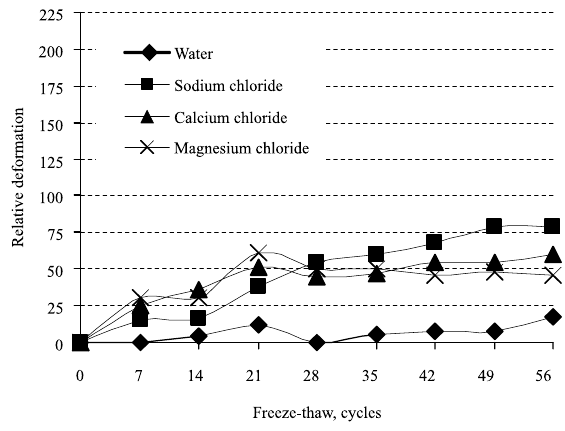
Fig. 6. Kinetics of ultrasonic pulse velocity in specimens made of Portland cement after 56 freeze-thaw cycles in different saline solutions